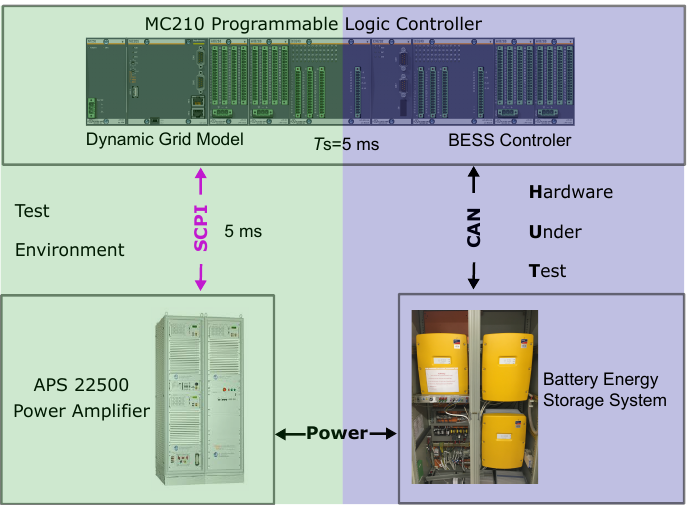
Figure 11. PHiL with digital communication between PLC and amplifier (Ethernet/SCPI) and between PLC and BESS (CAN